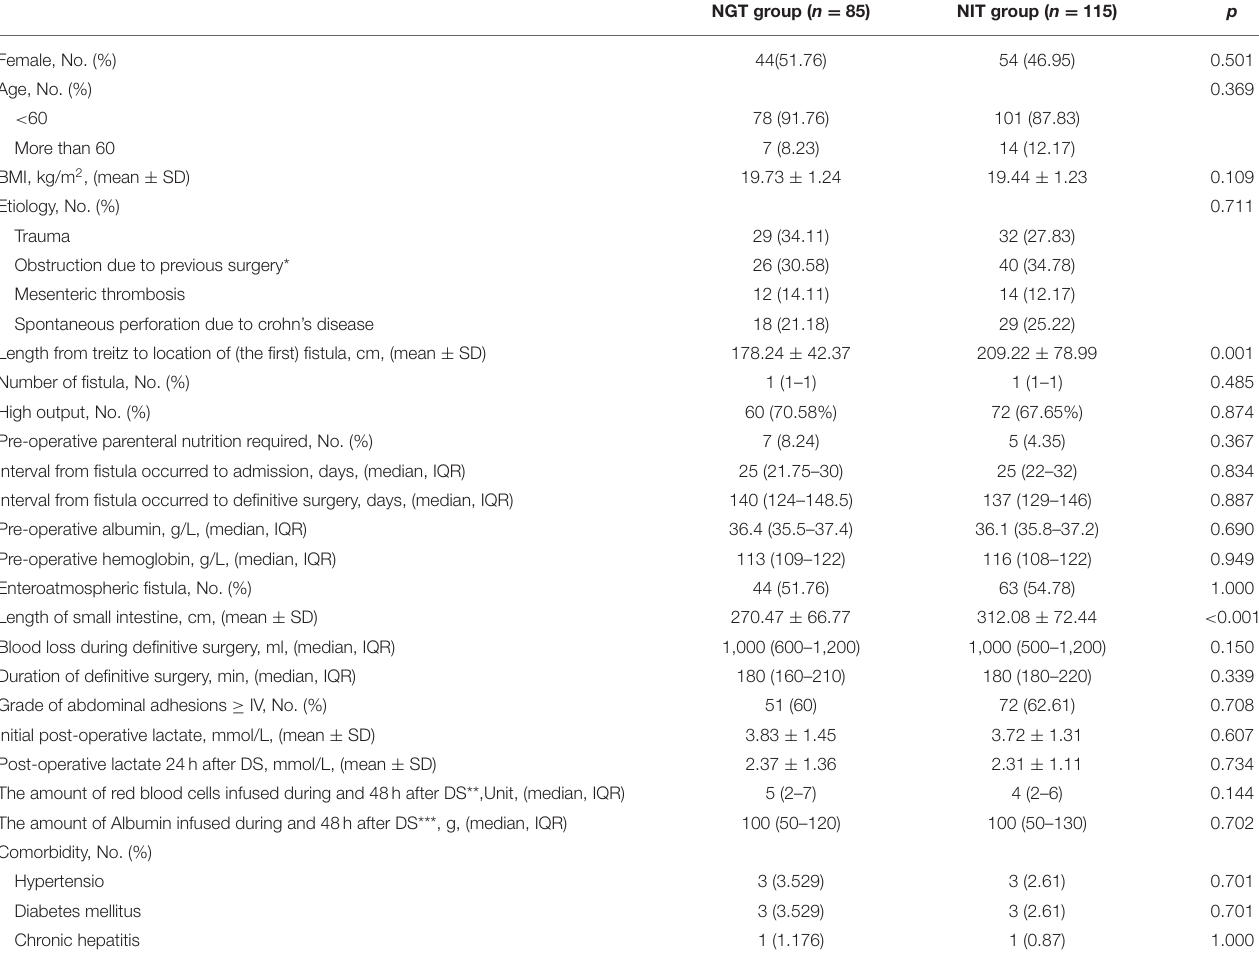
TABLE 1 | Baseline